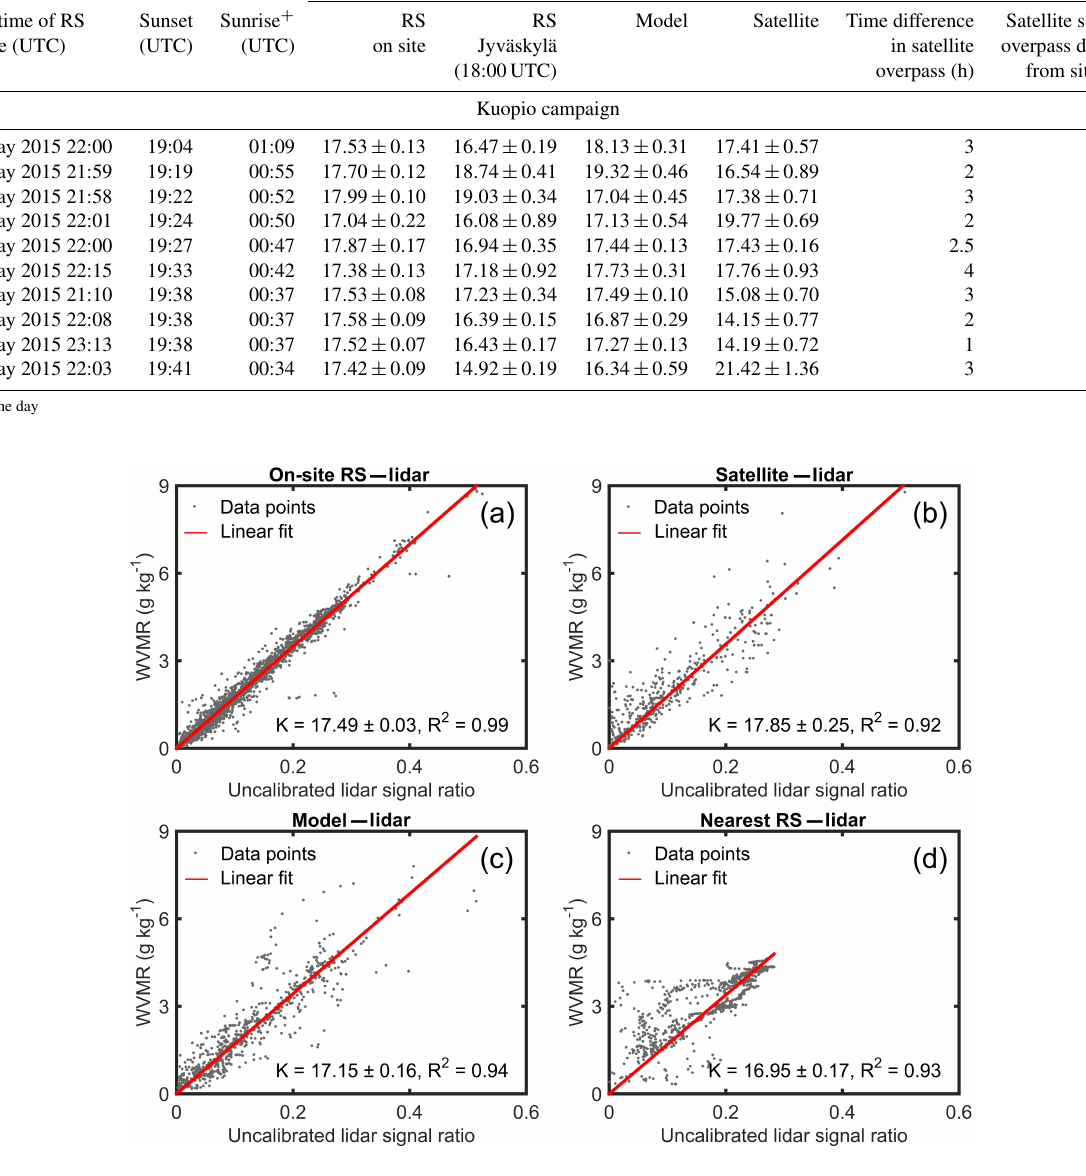
Figure 2. Overall calculation of the calibration factor including all available cases between the lidar and (a) on-site RS (b) the satellite, (c) the model and (d) the nearest RS (for Kuopio site only). Data points are marked as gray dots and the regression as red line. The calibration factor is also shown for each